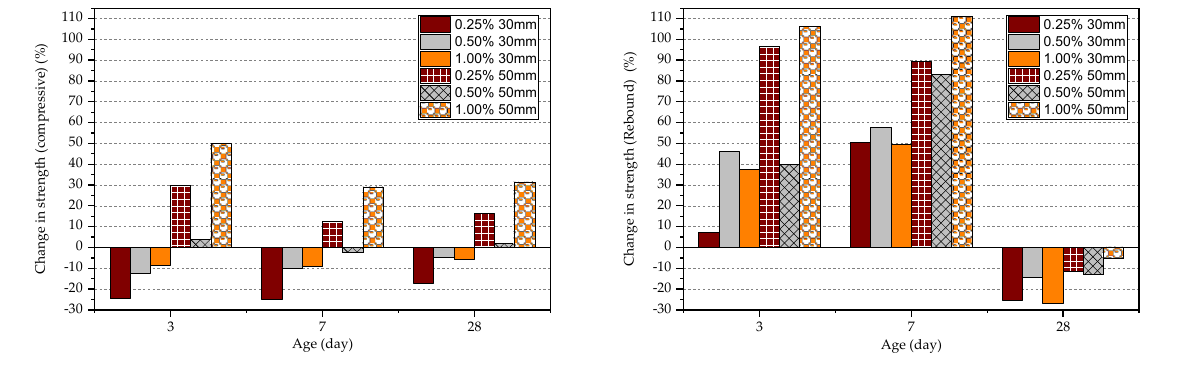
Figure 10. Percentage change in strength.